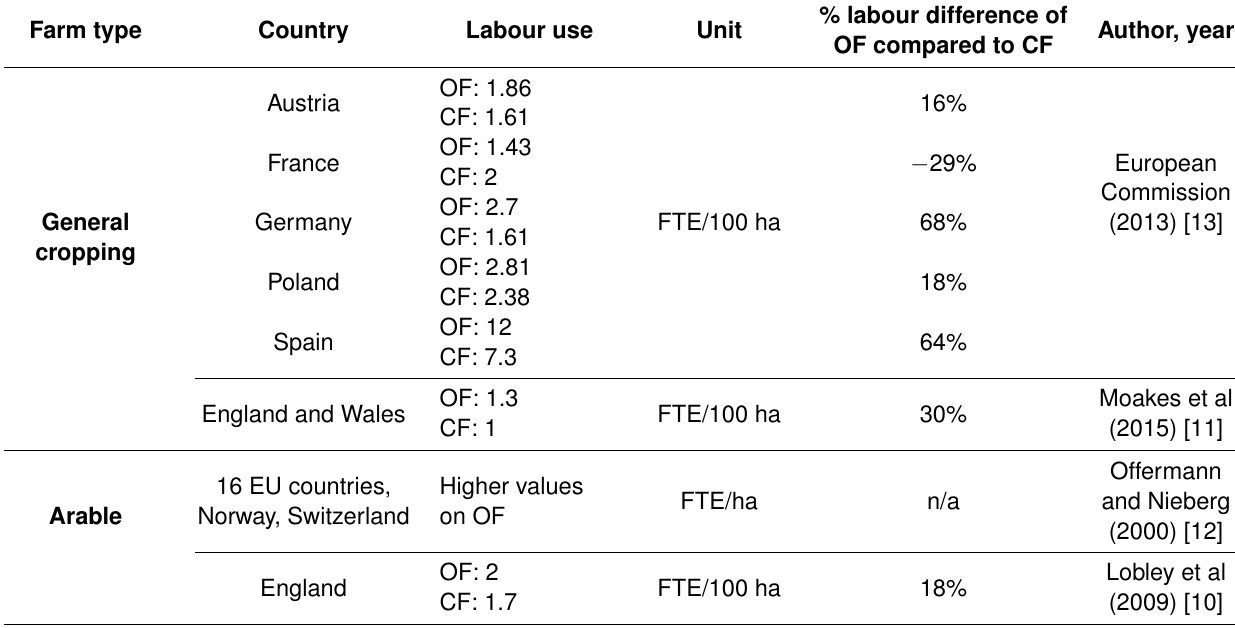
Table 1. Breakdown of labour use per hectare (ha) or per head of livestock by farm type OF = organic farms; CF = conventional farms; FTE = Full Time